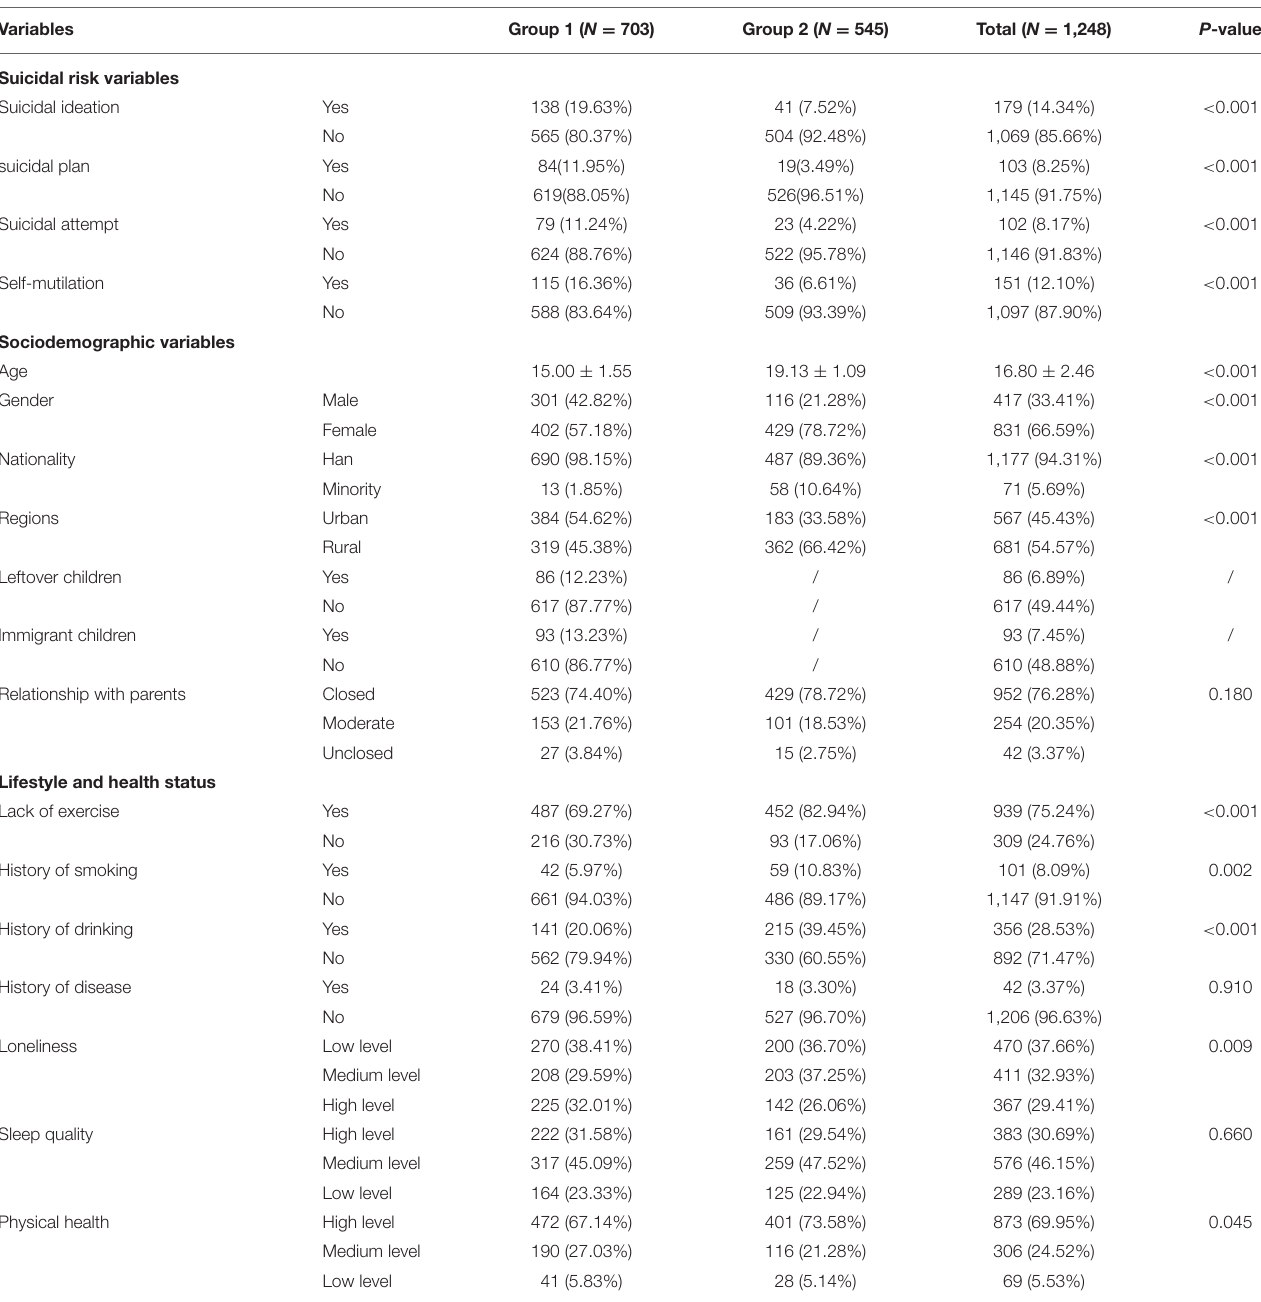
TABLE 1 | Suicidal risk and characteristics of adolescents.